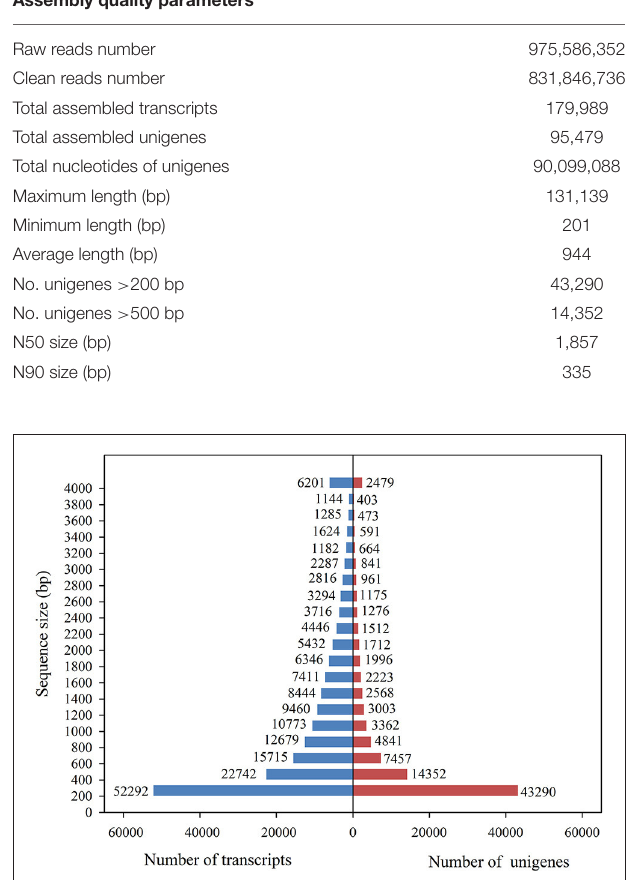
FIGURE 3 | Overview of the transcriptome assembly data for Alopecurus aequalis , showing the size frequency distributions of the transcripts and